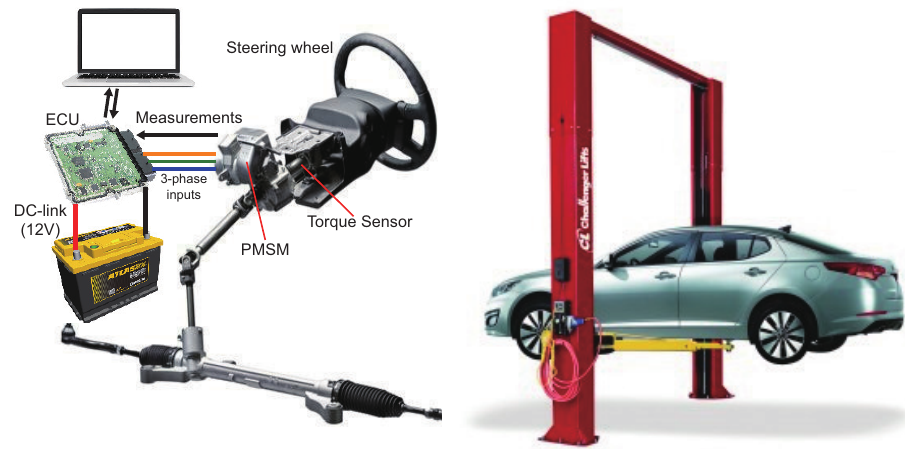
Figure 11. Hardware setup.